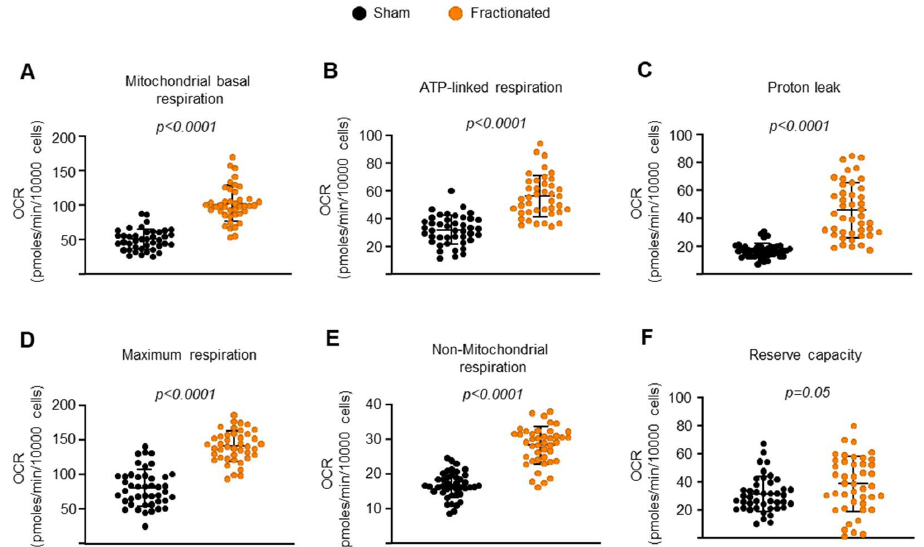
Figure 7. IR increases overall mitochondrial and non-mitochondrial respiration. ( A – F ) BMMs were isolated from 8.5-month-old male C57BL/6 sham- or IR-exposed mice 10 weeks after irradiation and cultured with M-CSF (30 ng/mL) and RANKL (30 ng/mL) for 3 days. ( A – D , F ) Different fractions of mitochondrial and ( E ) nonmitochondrial respirations per cell, in osteoclasts, measured by Seahorse ( n = 41–43 wells/group). Data are presented as ±SD. p values were determined using Student’s t test. ( n = 41–43 wells/group). Data are presented as ± SD. p values were determined using Student’s t